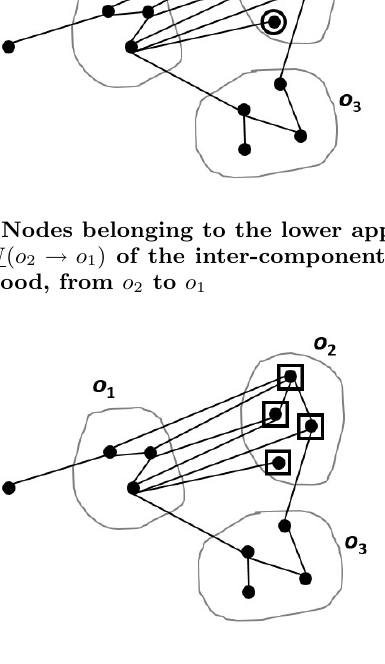
Figure 8: Nodes belonging to the β -lower approx- imation ICSN 0 . 25 ( o 1 → o 2 ) of the inter-component saccade neighborhood, from o 1 to o 2 saccade connections with respect to semantic meaning of object components. For example, we can use the approach based on decision systems over ontological graphs (cf.